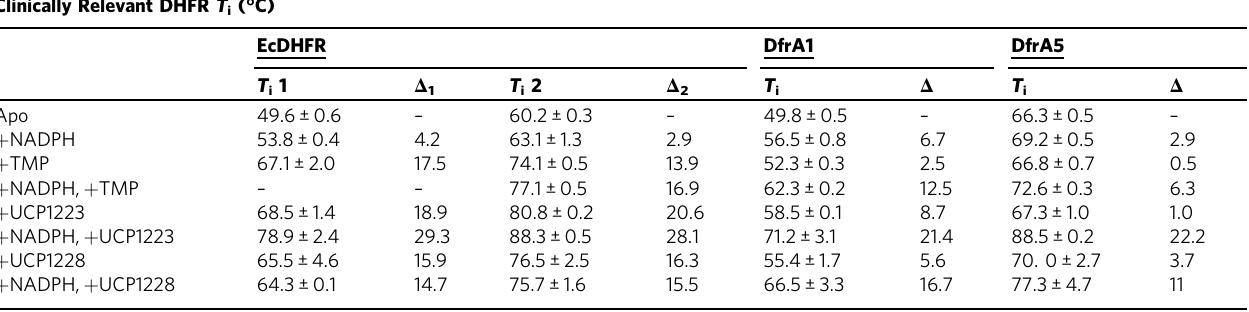
Table 4 Validation of different stabilizing effects of ligand binding on thermal stability of dihydrofolate reductases. Clinically Relevant DHFR T i (°C)